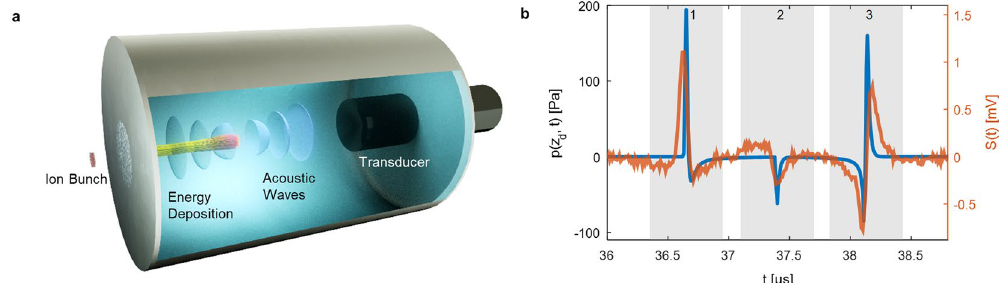
Figure 1. Experimental scheme of I-BEAT. ( a ) The short ion bunch enters the water volume via an 11 µ m thick titanium foil (1 cm diameter), depositing its energy in the water and generating an acoustic wave, which is measured via a transducer. This generates a signal as shown in ( b) , where the orange curve is an example trace for a mono-energetic 9.4 MeV proton bunch measured at the MLL Tandem accelerator and the blue curve represents simulated results, considering an ideal detector with equal